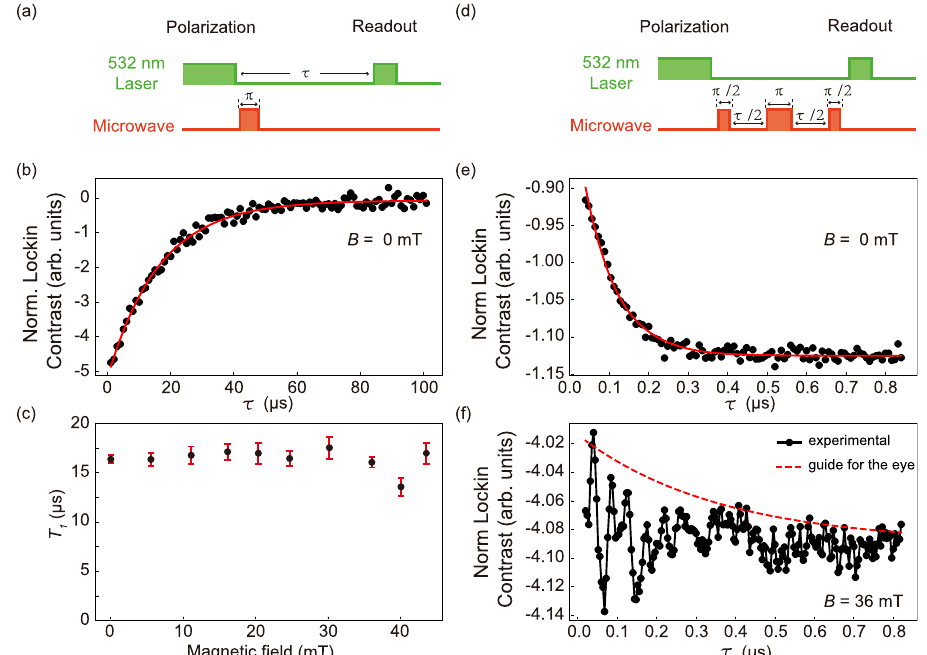
Fig. 3 | T 1 measurement and spin echo detections. a Pulse sequence for char- acterizing the spin-lattice relaxation dynamics, including the spin polarization and read-out laser pulse, the π -pulse microwave obtained from Rabimeasurement and the varying free evolution time τ . b T 1 measurement at 0 mT revealing the spin- lattice relaxation time of T 1 =16.377±0.416 μ s. c T 1 time versus magnetic fi eld, suggestingthatthereisroughlyno T 1 dependenceonmagnetic fi eld.Theerrorbars